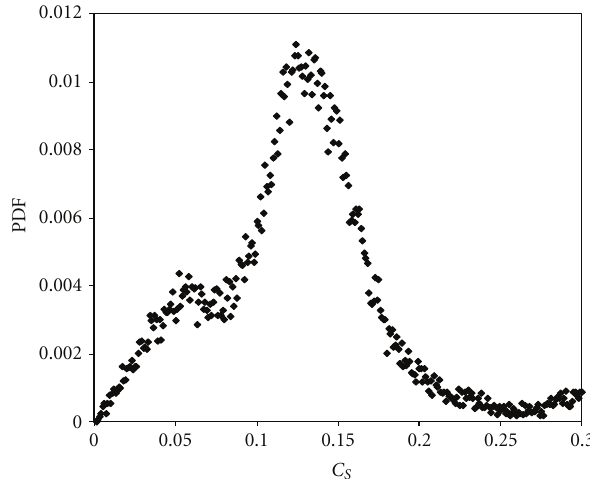
Figure 6: Probability density function for computed constant 𝐶 𝑆 in Germano model over entire column (from Dhotre et al.